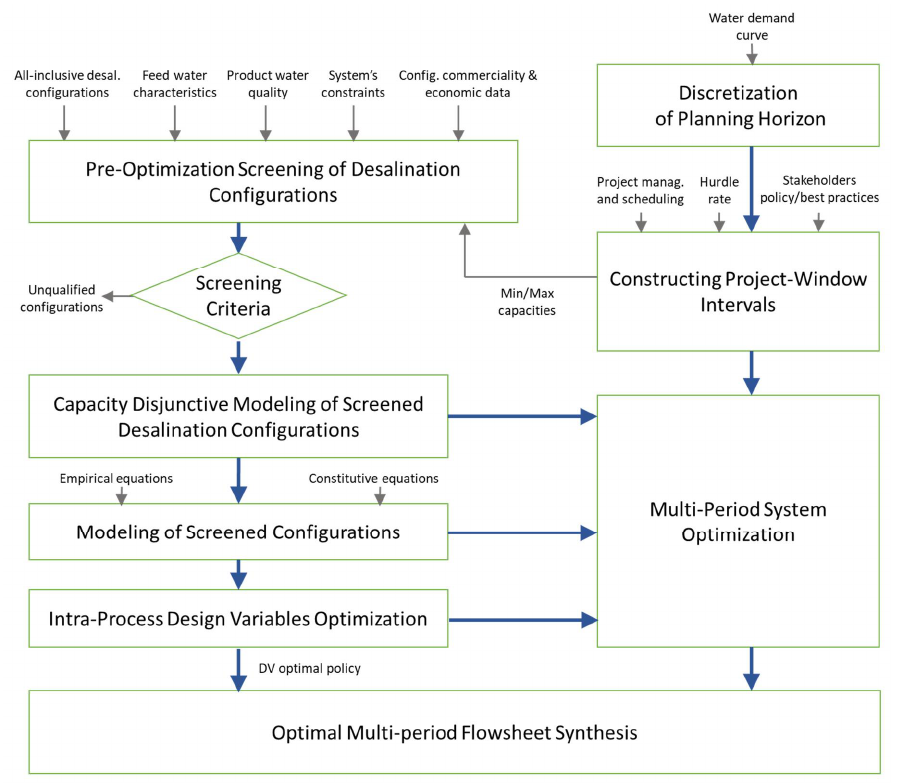
Figure 3. Optimization approach for the multiperiod capacity planning problem.